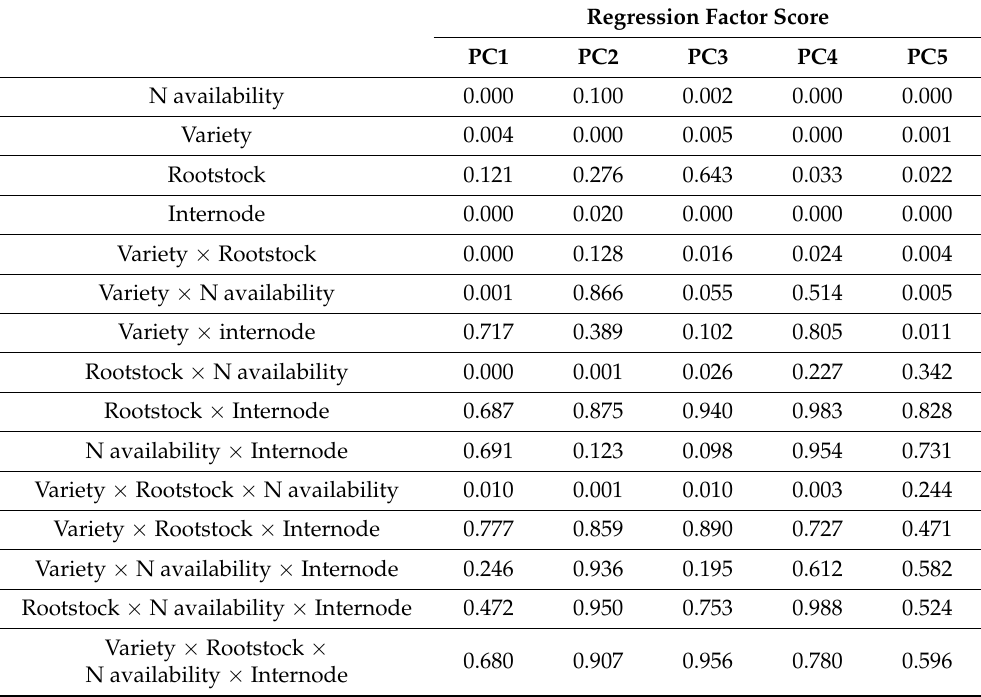
Table 2. Results of the ANOVA of the effects of N availability, variety, rootstock, and internode (and all their possible interactions) on the regression factor scores of the five functions with Eigen- values higher than 1 (PC = principal component).